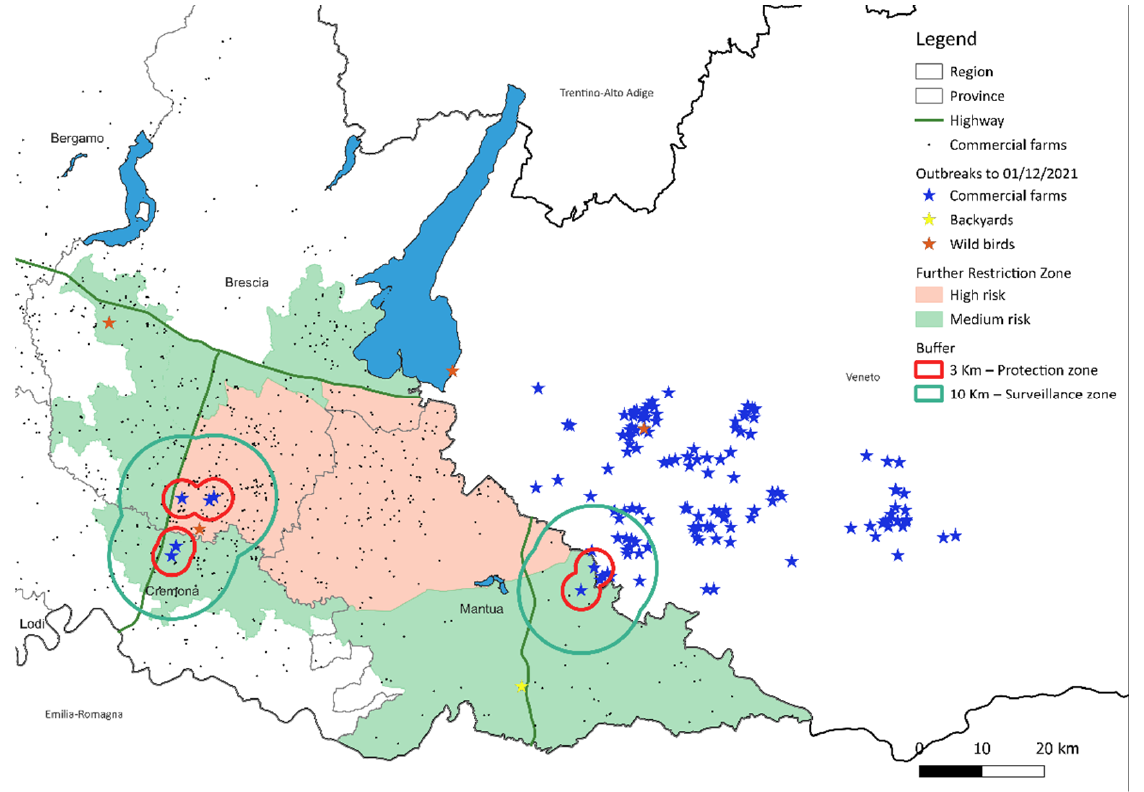
Figure 2. Map of outbreaks as at 1 December 2021 in Lombardy and in Veneto. Among the commercial establishments affected in Lombardy, the vast majority were large commercial establishments for laying hens (20/60) and fattening turkeys (20/60). Other farms kept broilers (9/60), domestic ducks for fattening (4/60), guinea fowl (1/60) and breeding chickens (1/60). The remainder were family flocks of poultry (5). Mortality or symptoms were reported for all the outbreaks. However, in the outbreaks (11)